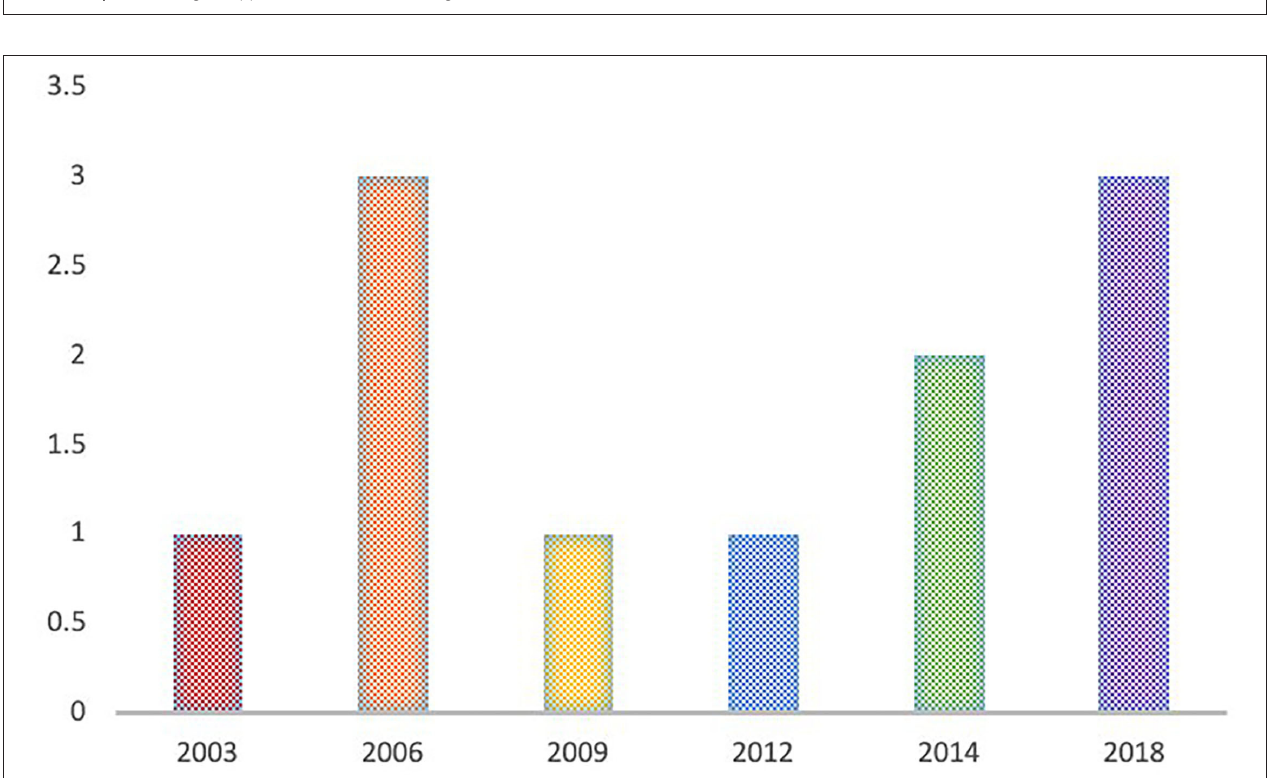
FIGURE 5 | Annual production of articles for tacit knowledge